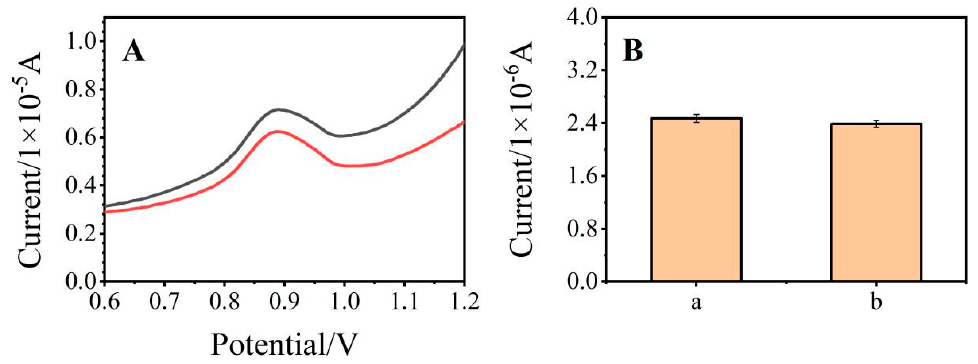
Figure 6. Differential pulse diagram ( A ) and current response ( B ) of the same electrode for SDZ detection five times (50 μ mol/L, ( a – e ) are first to fifth).